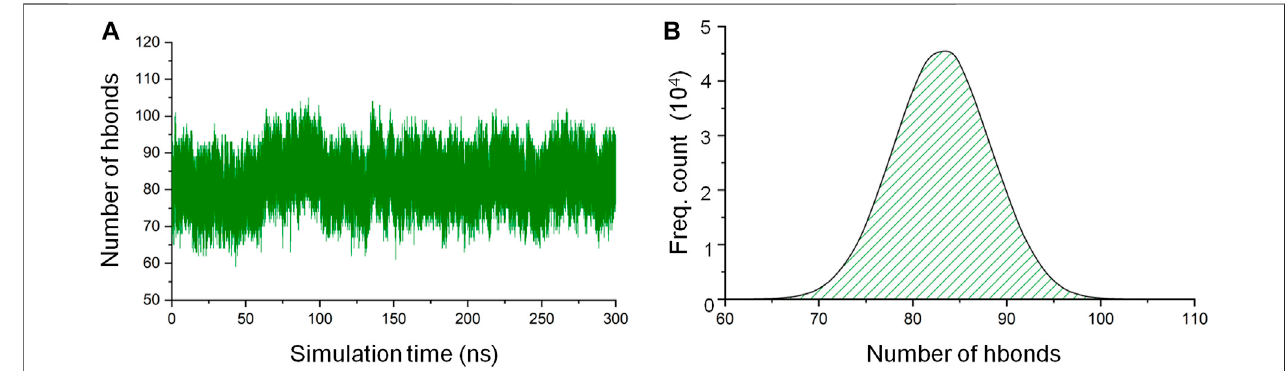
FIGURE 3 | CbtA intramolecular hydrogen bond (hbond) analysis data. (A) Hydrogen bond count. (B) Hydrogen-bond-count distribution curve.